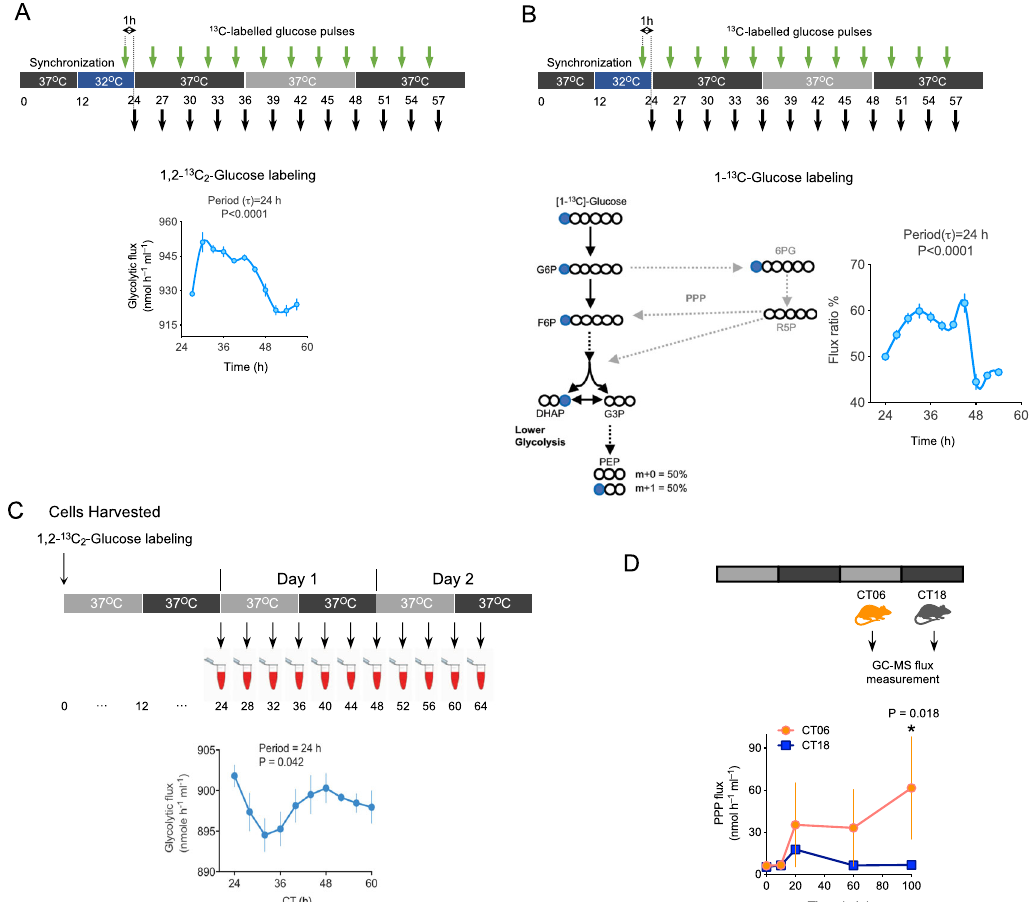
Fig. 4 Rhythmic metabolic fl uxes in human RBCs subjected to dynamic glucose labeling. A Schematic showing the sampling protocol for dynamic glucose pulse labeling and below calculated fl uxes from these labeling experiments. Oscillations of glycolytic fl uxes using either 1,2- 13 C 2 -glucose labeling are shown below the schematic. Data for 1,2- 13 C 2 -glucose fl ux are mean ± s.e.m ( n = 3 biological replicates). Samples were entrained with 12-h: 12-h 37 °C: 32 °C and maintained at constant conditions. B Independent validation of metabolic fl ux with isotope 1- 13 C1-Glucose. Schematic of 1- 13 C1-Glucose labeling and calculation of PEP isotopomer ratio to calculate glycolytic fl ux ratio. G6P = Glucose-6-phosphate, G3P = Glyceraldehyde 3-phosphate, F6P = Fructose- 6-phosphate, DHAP = Dihydroxyacetone phosphate, PEP = Phosphoenolpyruvate, R5P = Ribose-5-phosphate, 6PG = 6-Phosphogluconate. Glycolytic (fgly) fl ux ratio for 1- 13 C 1 -glucose experiments was determined using the mass isotopomer distribution of Phosphoenolpyruvate (PEP). Data for 1- 13 C 1 - glucose fl ux ratio are mean ± s.e.m ( n = 4 biological replicates). P -values report signi fi cance by ANOVA (effect of time). C Schematic showing the sampling protocol for calculated fl uxes from 1,2- 13 C 2 -glucose labeling experiments. Oscillations of glycolytic fl uxes are shown below the schematic. Data for 1,2- 13 C 2 - glucose fl ux are mean ± s.e.m ( n = 3 biological replicates). P -values were obtained from rhythmicity analysis using RAIN algorithm Note these data are replotted from Fig. 3F to compare phase of glycolytic fl ux to Fig. 4A. D Measurement of RBC fl ux in circulating mouse RBCs at opposite circadian phases. Mouse RBCs ( n = 3 biological replicates) were harvested at opposite phases of the circadian cycle (see schematic): CT06 and CT18 (CT, circadian time: subjective day CT00-CT12; subjective night CT12-24). P -values report signi fi cance by one way